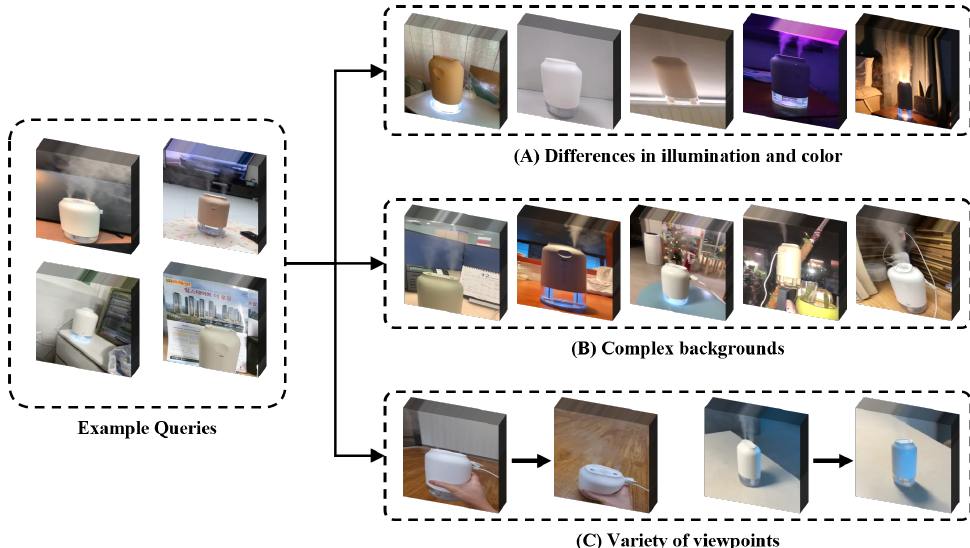
Figure 4. An example of VERD in “Humidifier”